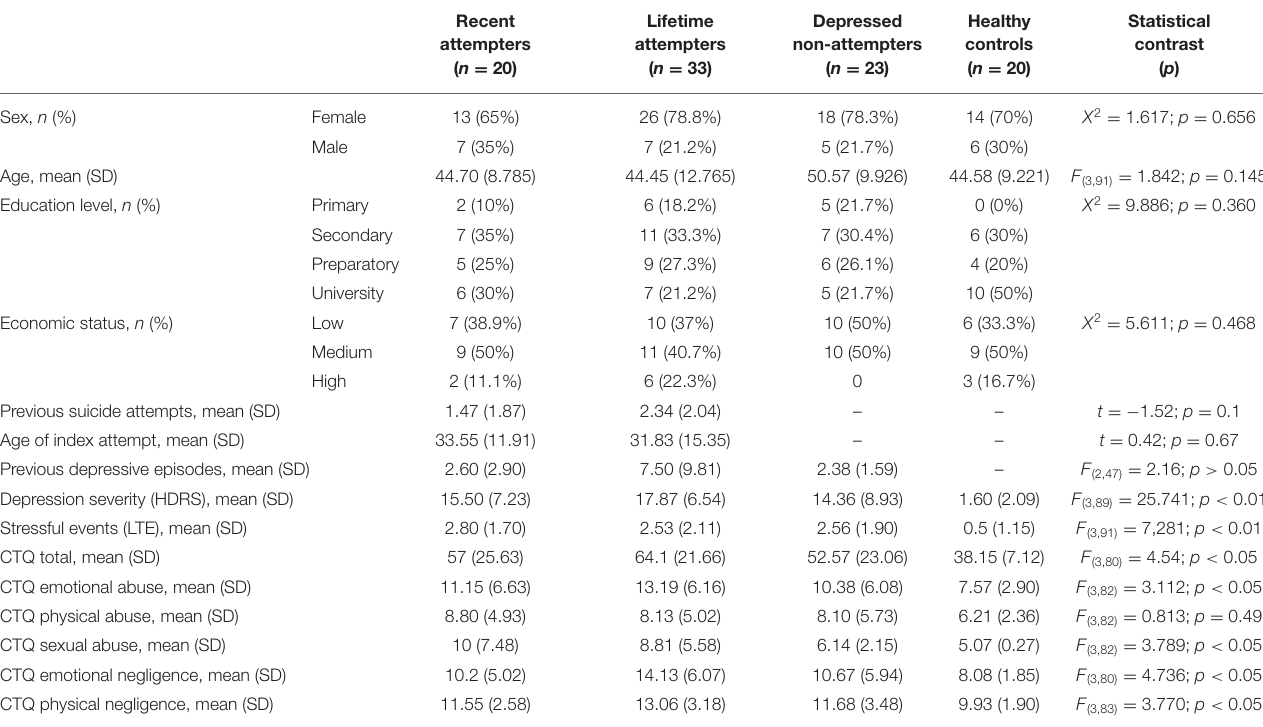
TABLE 2 | Demographic and clinical